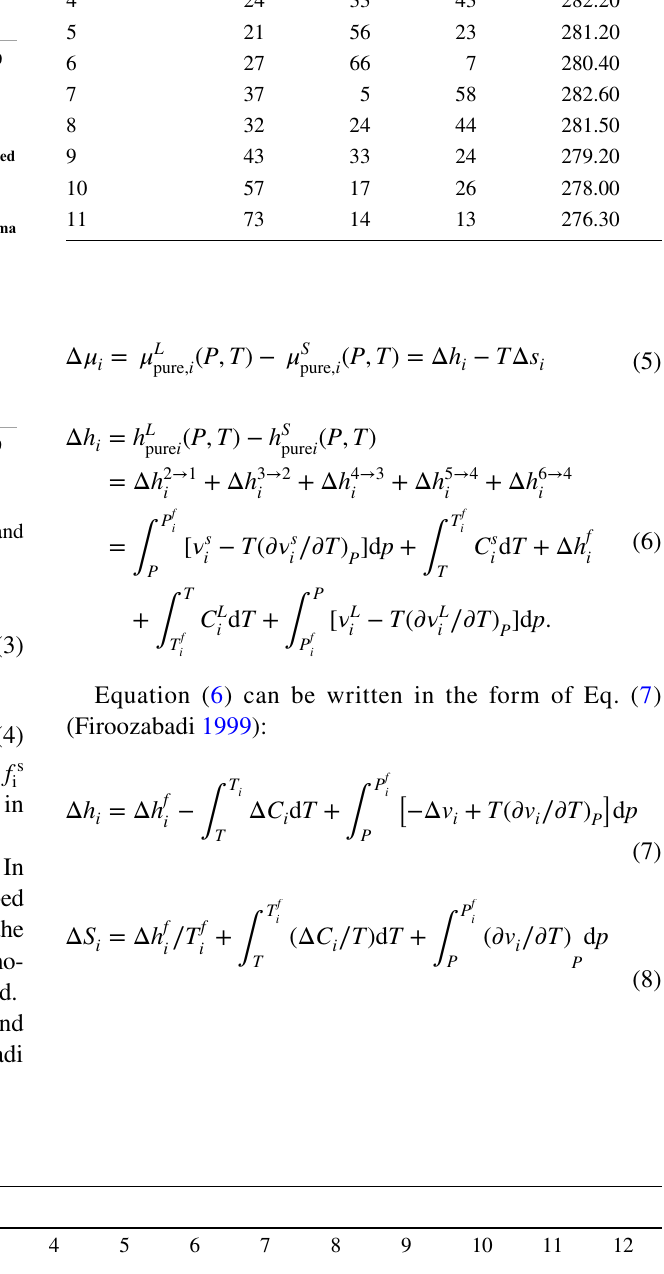
Table 2 Average absolute deviation of plus fraction splitting of 12 crude oil and condensate samples using gamma probability function and Ahmed method